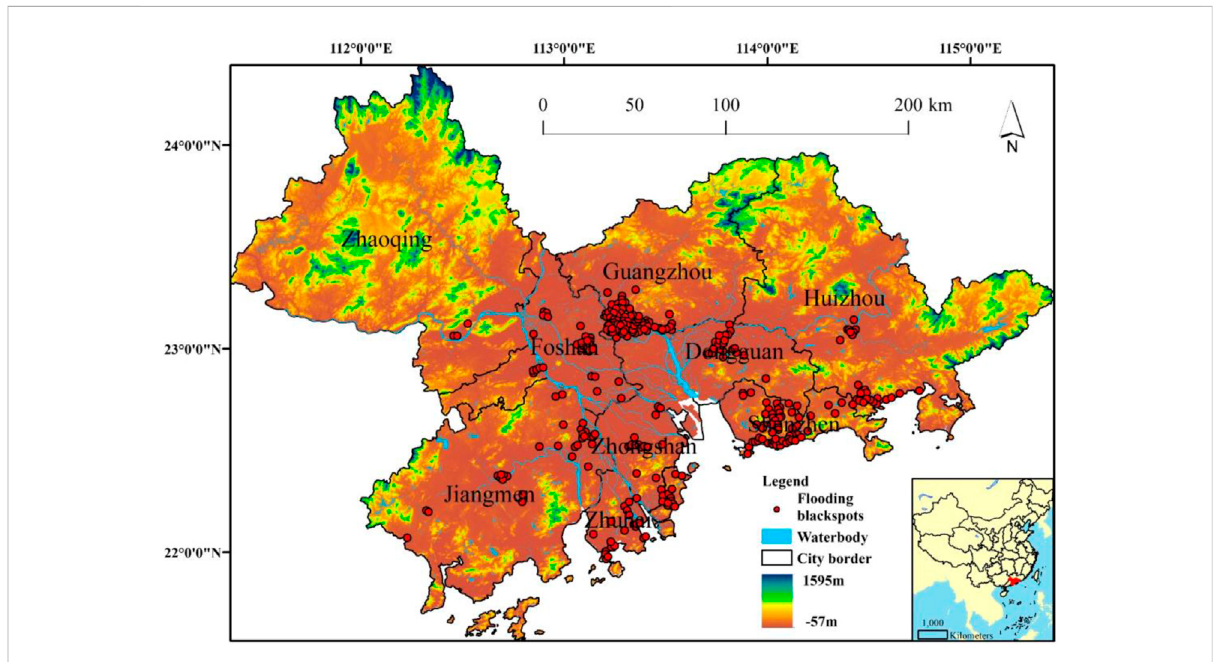
FIGURE 1 Research region and the spatial distribution of the fl ooding